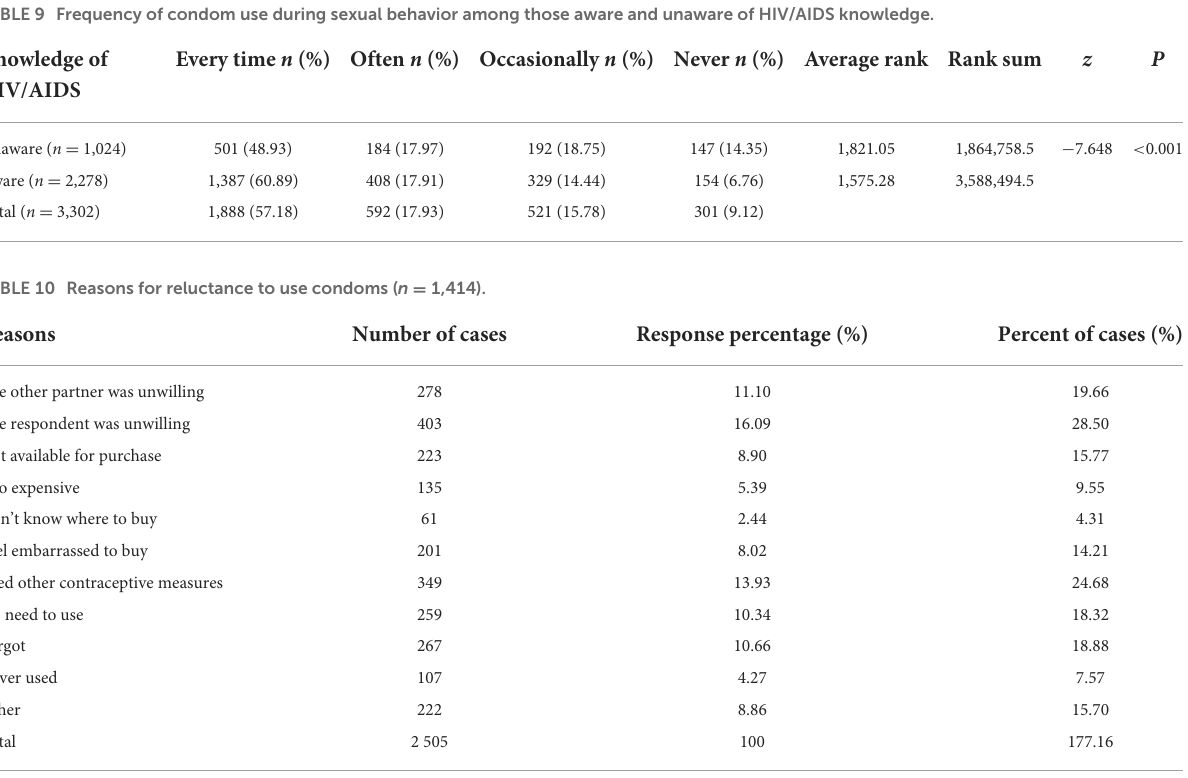
TABLE 9 Frequency of condom use during sexual behavior among those aware and unaware of HIV/AIDS